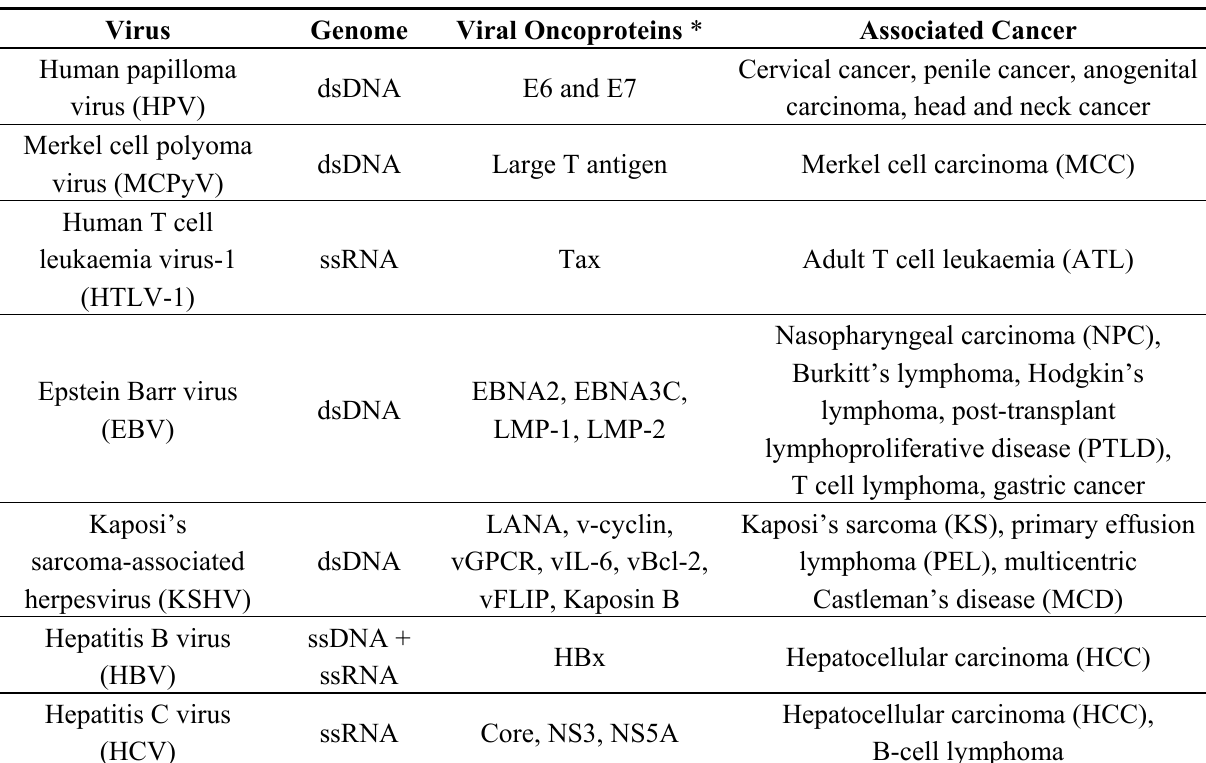
Table 1. Known human tumour viruses. * Includes well-characterised proteins rather than an exhaustive